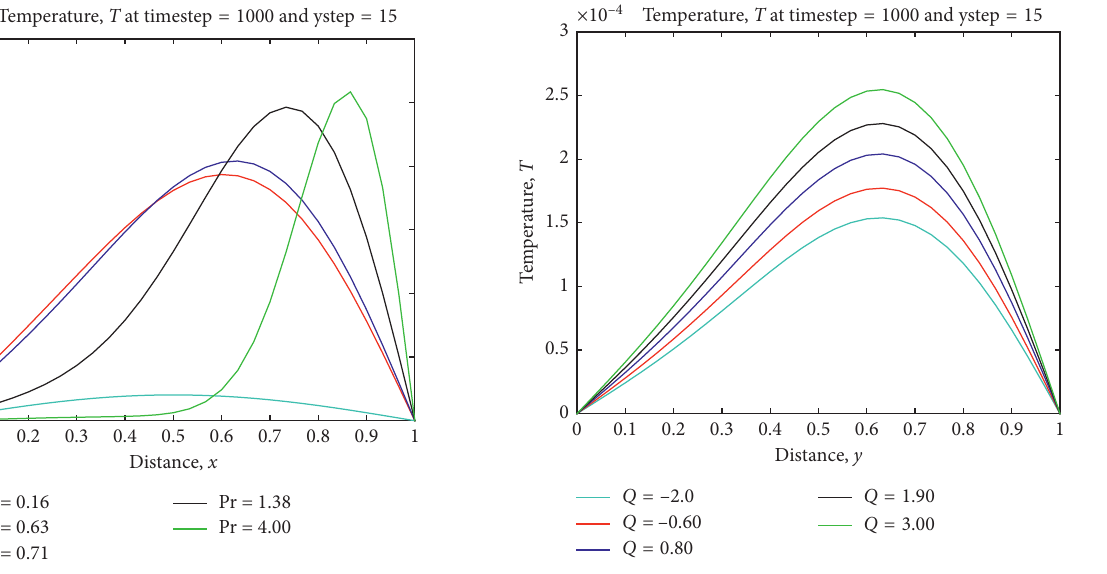
Figure 6: Graph of effects of the Prandt number on temperature profile T .